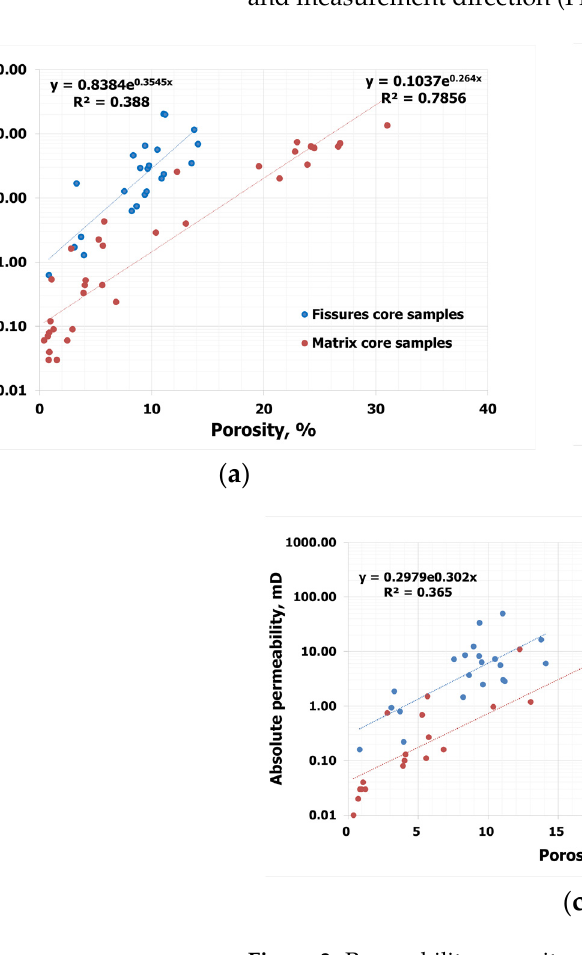
( c ) Figure 4. Permeability arrays (plane view): ( a ) X-direction, ( b ) Y-direction, ( c ) Z-direction.